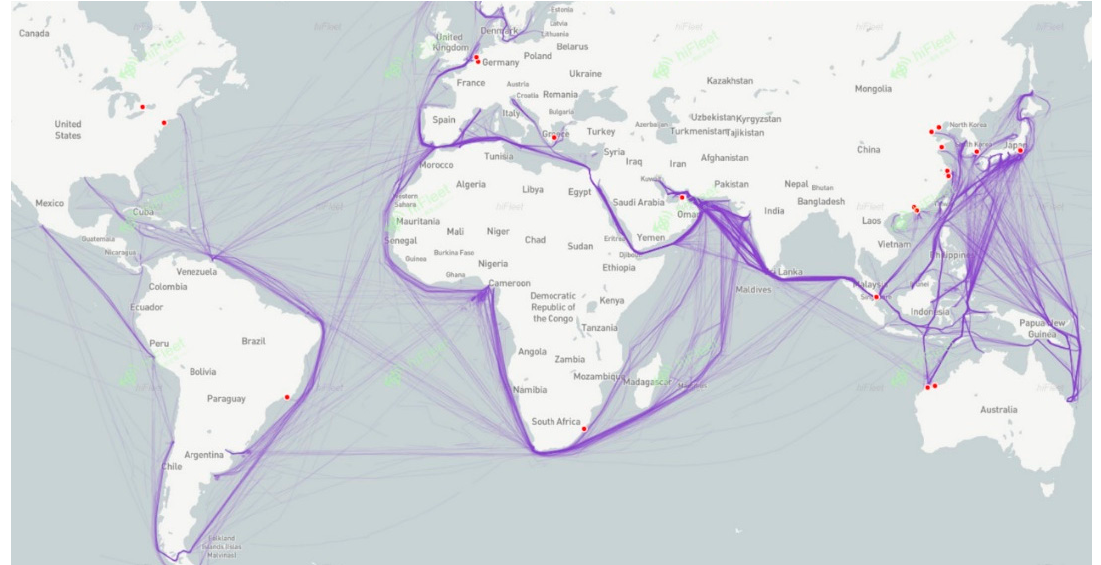
Figure 1. 2018 global (liquefied natural gas) LNG automatic identification system (AIS) trajectory data.